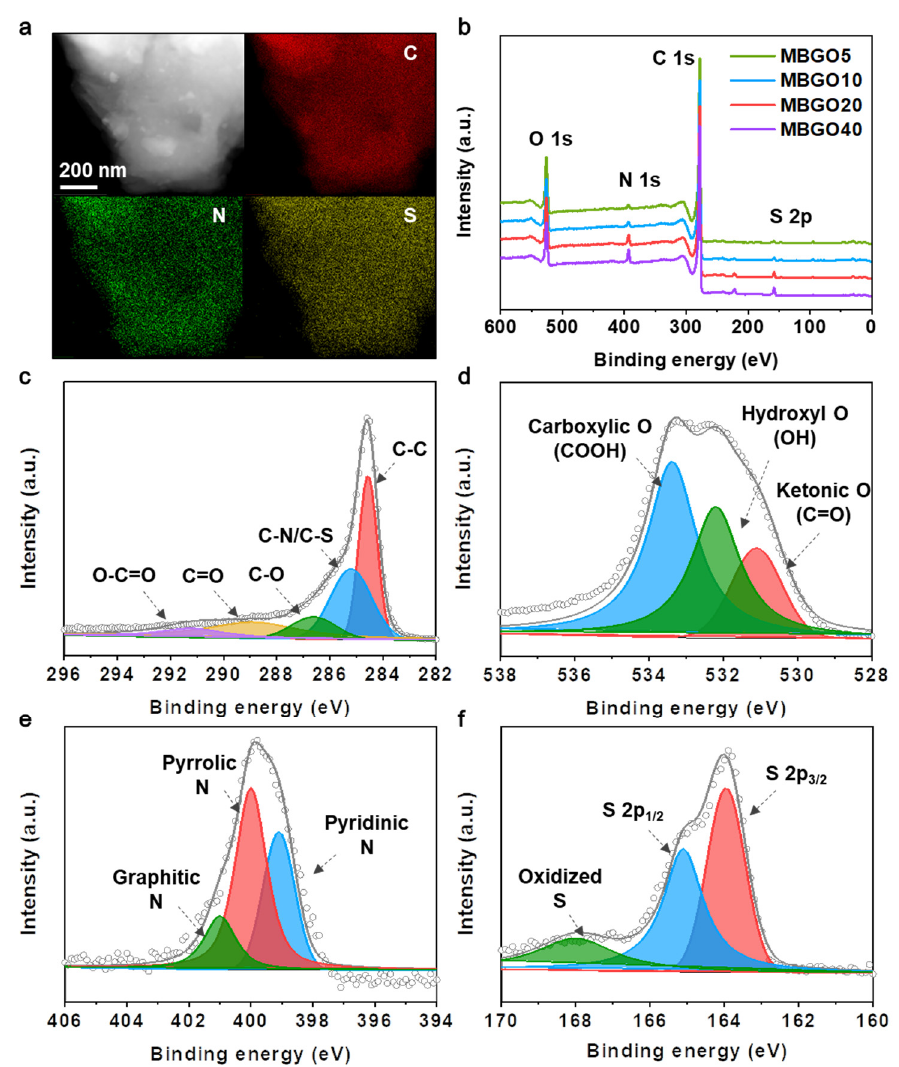
Figure 2. ( a ) STEM image and corresponding elemental mapping images of C, N and S for MBGO20. ( b ) XPS survey spectra with different MB contents. The high-resolution XPS spectra of ( c ) C 1s, ( d ) O 1s, ( e ) N 1s and ( f ) S 2p of the MBGO20.